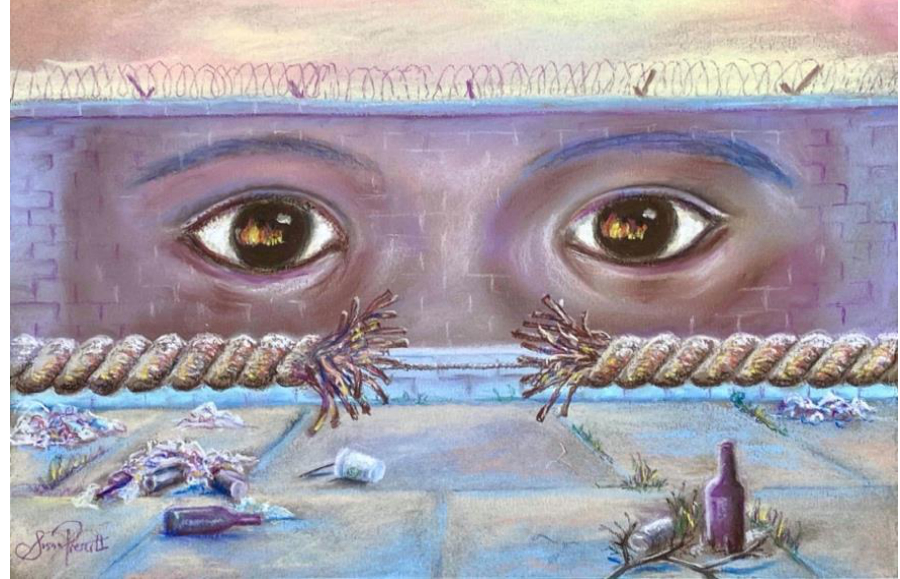
Figure 3. “Common Threads”: broken relationships in all systems. In broad terms, many of our personal, local, and global challenges arise from broken relationships — with each other, with our communities, with nature, and even with our own sense of purpose. Solutions must lie in restoring bonds, including emotional bonds, for benefits across these scales. (Art created by author S.L.P.).